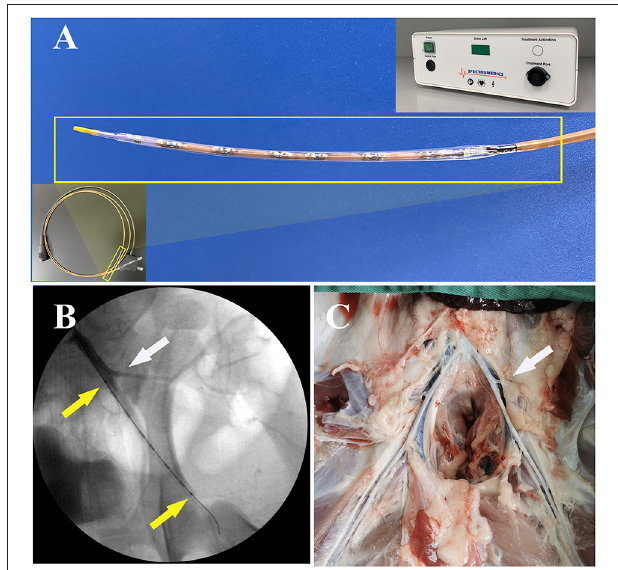
FIGURE 1 | Configuration of the IVL device, angiography during the IVL procedure, and gross observation of the same animal at 28 days postoperatively. (A) The IVL catheter with multiple shock wave emitters was mounted in a semi-compliant balloon. Bottom left inset: Overall image of the IVL catheter. Top right inset: Portable control system. (B) Markers at both ends of the IVL balloon are clear (yellow arrows). The collateral artery (white arrow) was used to confirm the treated vessel segment location. (C) Gross in situ observation of treated vessel segments at 28 days postoperatively. The treated arterial segment location was determined by matching with the collateral artery (white arrow). IVL, intravascular lithotripsy.